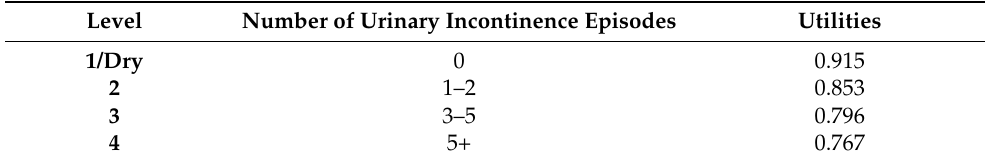
Table 2. Cost and utility values of complications.